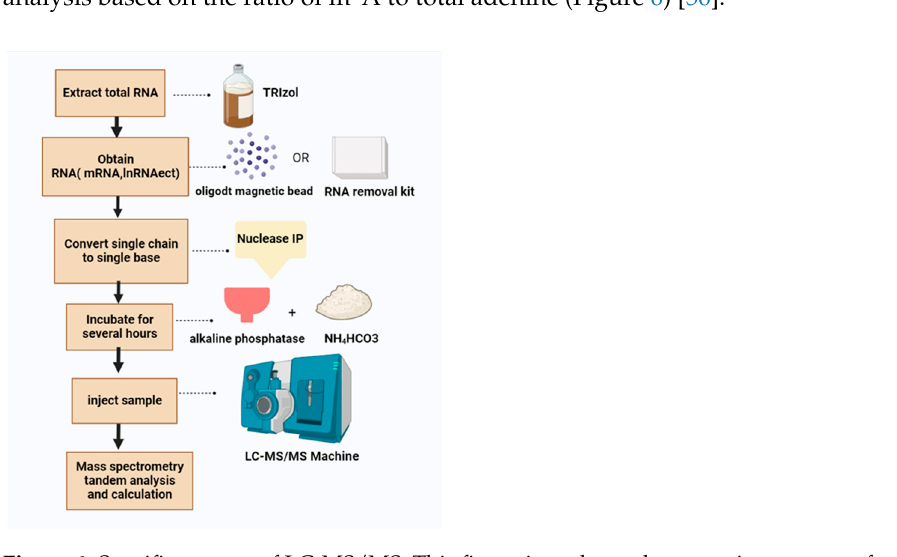
Figure 6. Specific process of LC-MS/MS. This figure introduces the operation process of